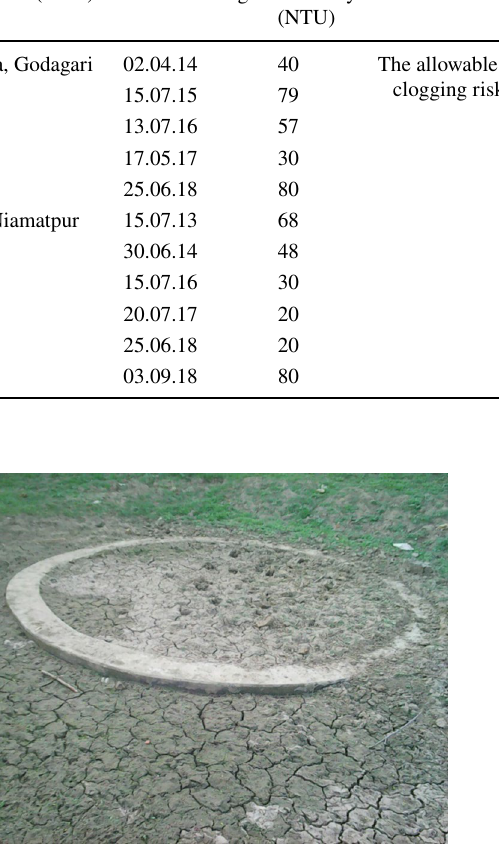
Table 2 Turbidity value for the tested sample of surface water ( Khari water) Name of Khari (canal)